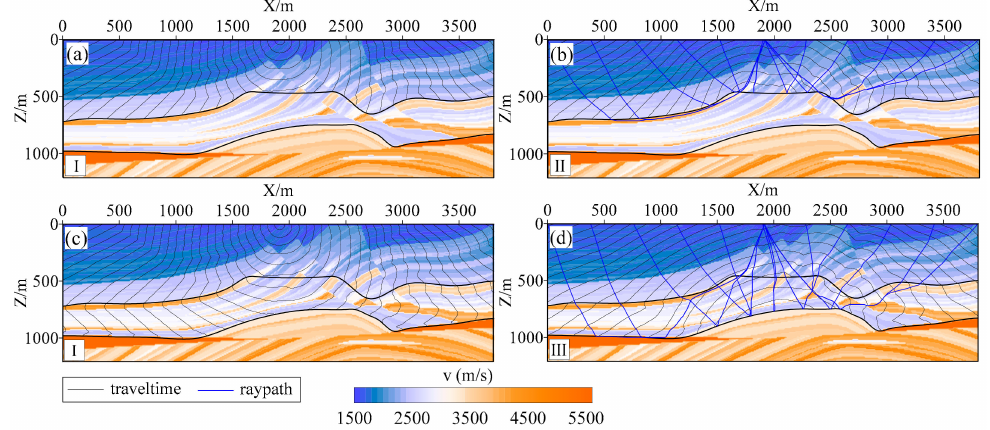
Figure 12. MFMM primary reflection waves ray tracing. The wavefront of the down-going wave from the source to ( a ) interface 1 and ( c ) interface 2. The wavefront of the reflection waves and raypath of ( b ) interface 1 and ( d ) interface